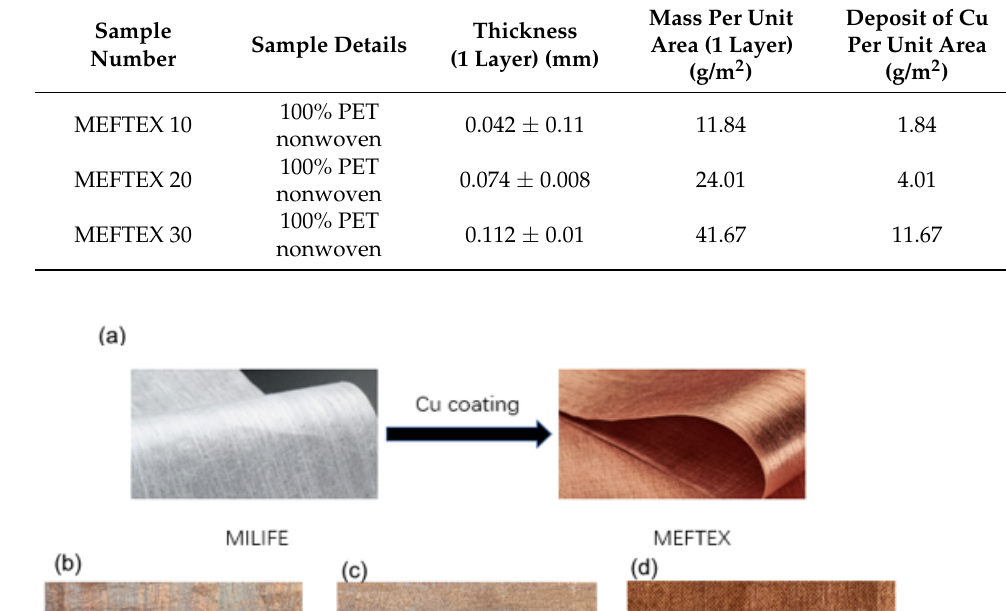
Table 1. Characteristics of the